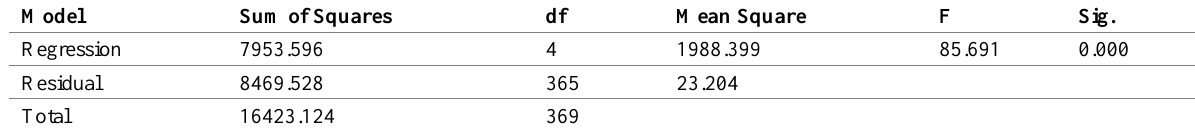
Table 9: F / Simultaneous Test Results